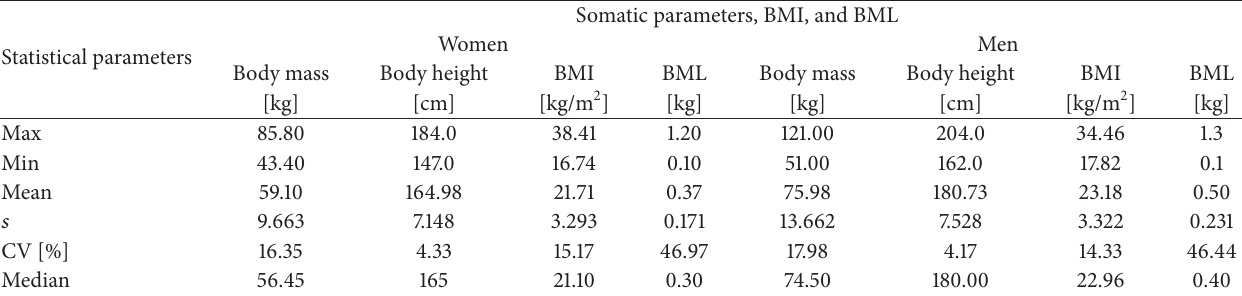
Statistical parameters